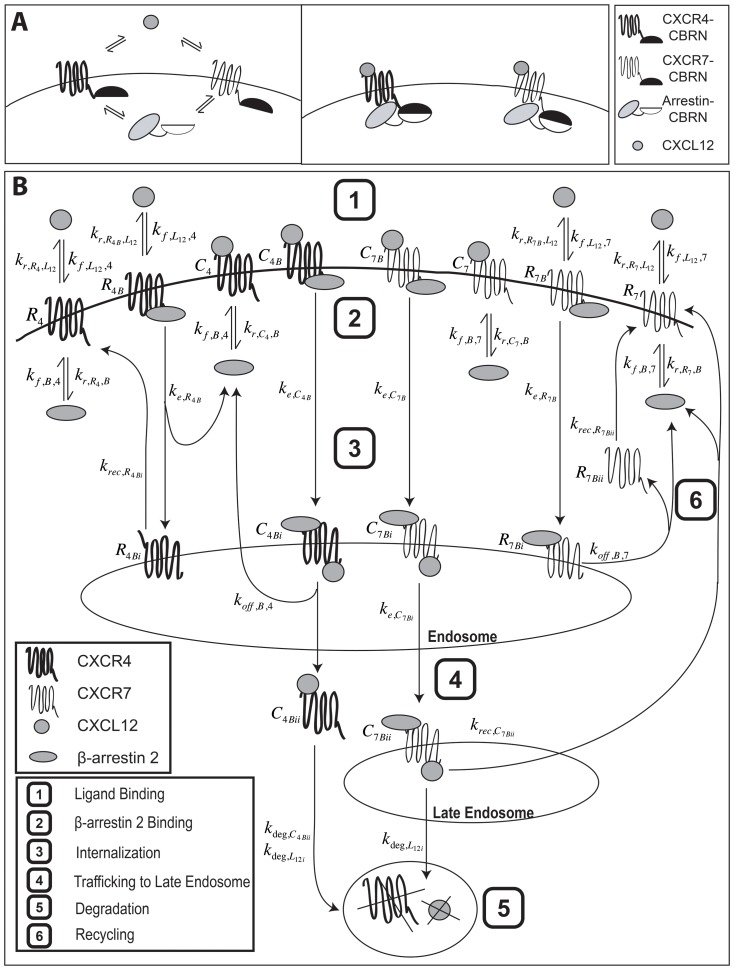
Diagrams of click beetle complementation reporters and computational model of β-arrestin 2 recruitment to CXCR4+ or CXCR7+.(A) Schematic of luciferase complementation reporters for CXCR4 or CXCR7 interaction with β-arrestin 2. (B) Model schematic of receptor dynamics for CXCR4+ cells (left) and CXCR7+ cells (right) with β-arrestin 2. Note that chematic does not distinguish between endogenous β-arrestin 2 and β-arrestin 2-CBC.